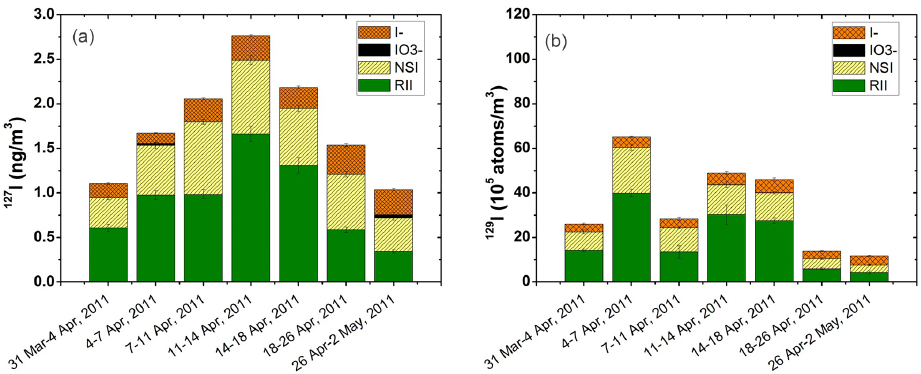
Figure 4. Concentrations of iodine species in the aerosol samples for 127 I (a) and 129 I (b) , indicating that NSI and RII are major iodine species and that iodide is the dominant fraction of water-soluble iodine.